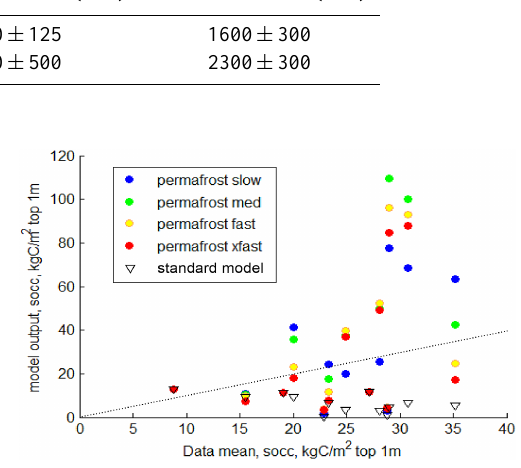
Figure 16. Modelled SOCC (kgCm − 2 ) for the top 1m plot- ted against SOCC data for the top 1m of soil upscaled to the CLIMBER-2 grid scale. Circles are for the permafrost-carbon model (CLIMBER-2P); triangles are for the standard model (CLIMBER-2). Dotted line shows the 1 : 1 position. Points are SOCC kgCm − 2